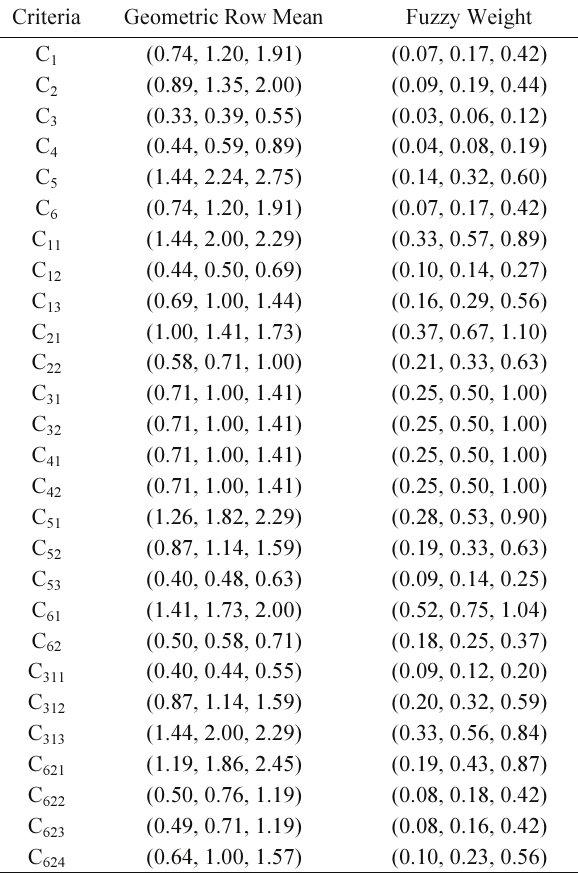
Table 3. Geometric row mean and fuzzy weights for each